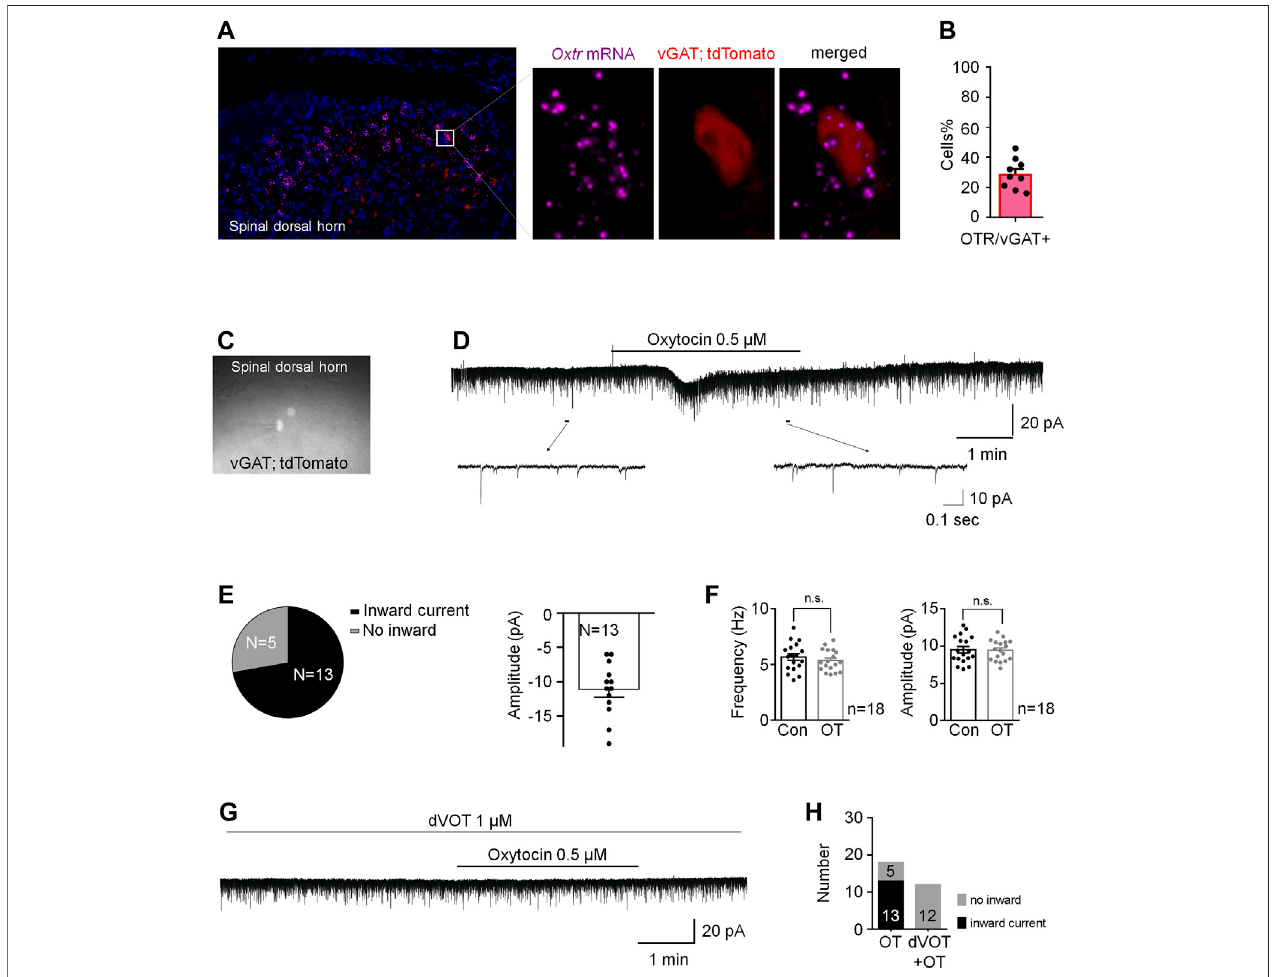
FIGURE 6 | OT produced an inward current in vGAT+ neurons through activation of Oxtrs in the super fi cial dorsal horn. (A) RNAscope showed that Oxtrs (pink) wereexpressed ontheinhibitoryneurons(red) inthespinaldorsalhorn.Co-expressionofasampleinhibitoryneuron(red)andthepunctarepresentingOxtrs(pink)inthe enlarged image. DAPI was used to stain the cell nuclei (blue). (B) percentage of Oxtrs expressed in the vGAT + neurons. (C) The vGAT + interneurons in the super fi cial dorsalhorn. (D,E) OTperfusion produced aninward currentin72%recordedvGAT+neurons( n =18). (F) Thefrequencyandamplitude ofspontaneousEPSCs in allexaminedvGAT+neurons.Paired t -test. Dataareexpressedasmean±SEM. (G,H) Selective OxtrantagonistdVOT(1 μ M)blocked OTinducedinwardcurrentsinall recorded vGAT positive interneurons in the super fi cial dorsal horn ( n = 12).